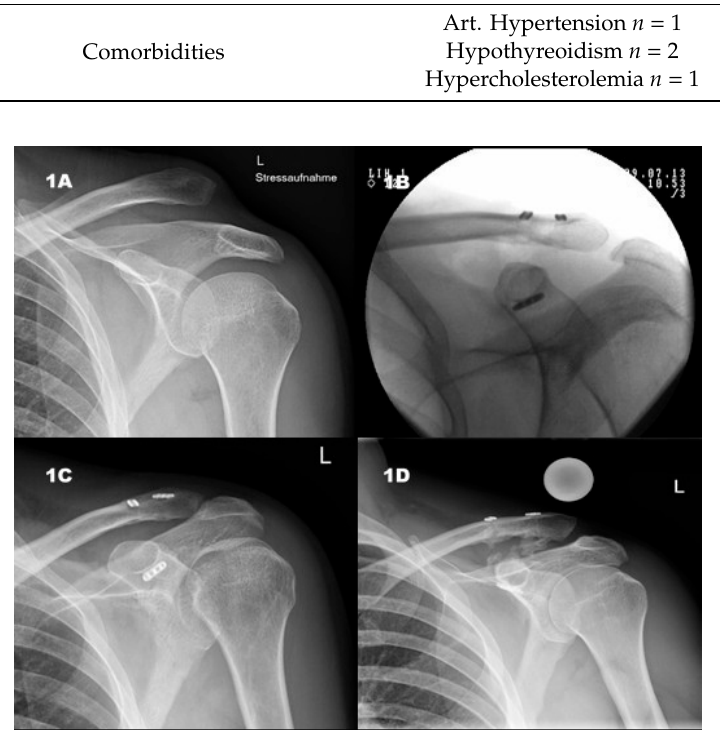
Figure 1. ( 1A ) Preoperative, Rockwood V lesion, intraoperative, ( 1B ) intraoperative, V-shaped array; ( 1C ) postoperative, anatomical reduction; ( 1D ) follow-up, stress view, slight loss of reduction, CC-ligament calcification.